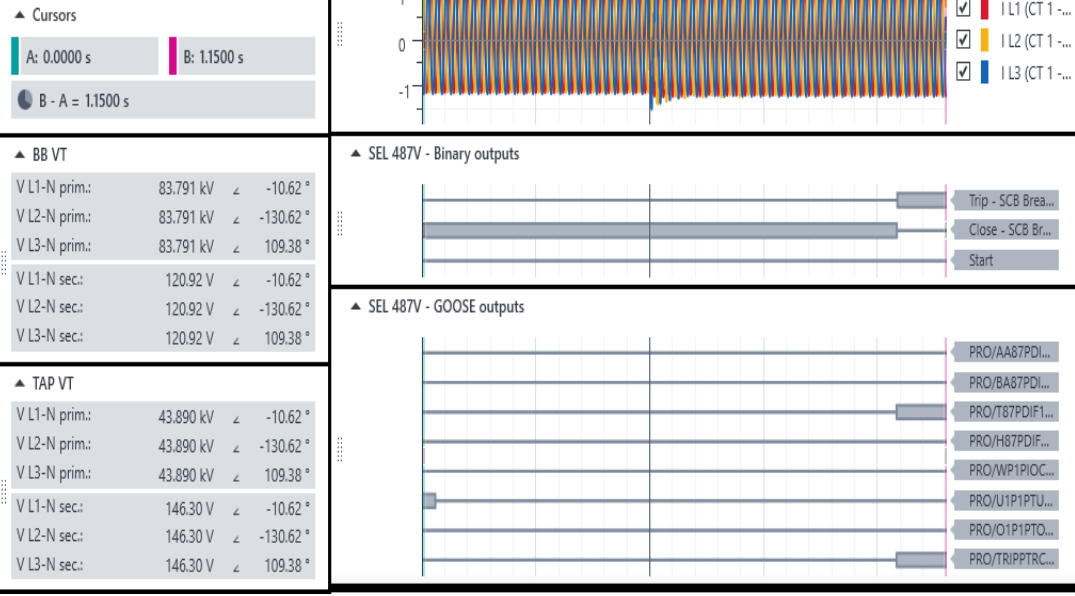
Figure 4. RelaySimTest simulation results for four-element failures below the tap. Table 3. A Summary of the results for four-element failures below the tap. Four Capacitor Element Failures below the Tap RelaySimTest